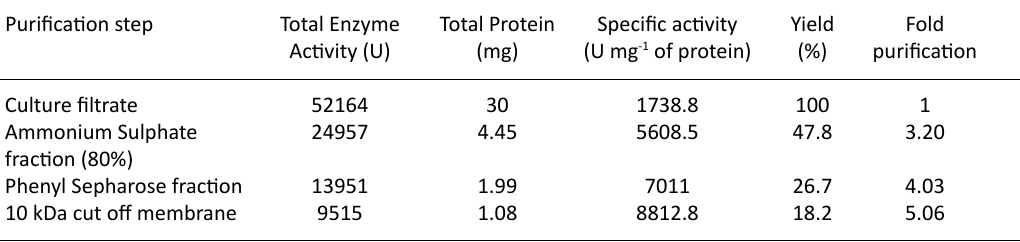
Table 1. Purification of β-mannanase by ammonium sulphate, phenyl sepharose and ultrafilteration from P. thiaminolyticus culture filtrate Purification